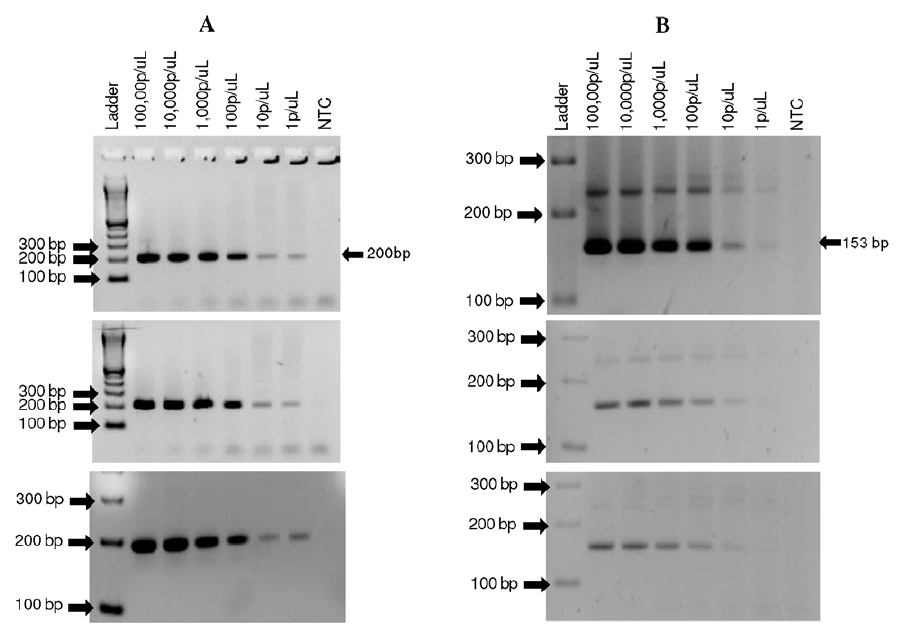
Figure 5. Limits of detection of primer set Pkr140-5. The analytical sensitivity of primer set Pk140-5 (A) and the primers from a published study [3] (B) were determined using a well-quantitated P. knowlesi DNA standard. The blood sample was serially diluted ten-fold with a starting parasitemia of 100,000p/ m l to 1p/ m l. The expected base pair sizes for the two primers are included. Three different experiments are shown.